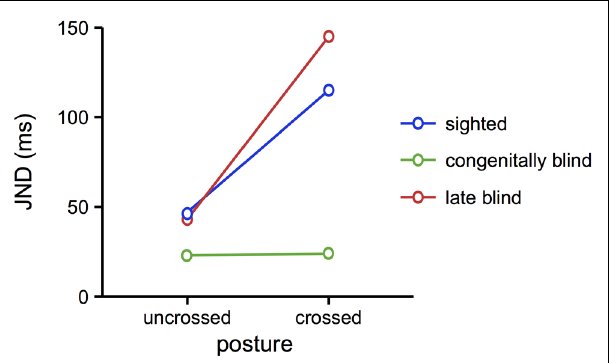
crossed hands. In contrast, late blind individuals and sighted participants showed the typical crossing effect, with larger JND in the crossed posture. These results suggest that the automatic use of external coordinates in touch localization depends on visual development during ontogeny. Figure modified from Röder etal. (2004), with permission from